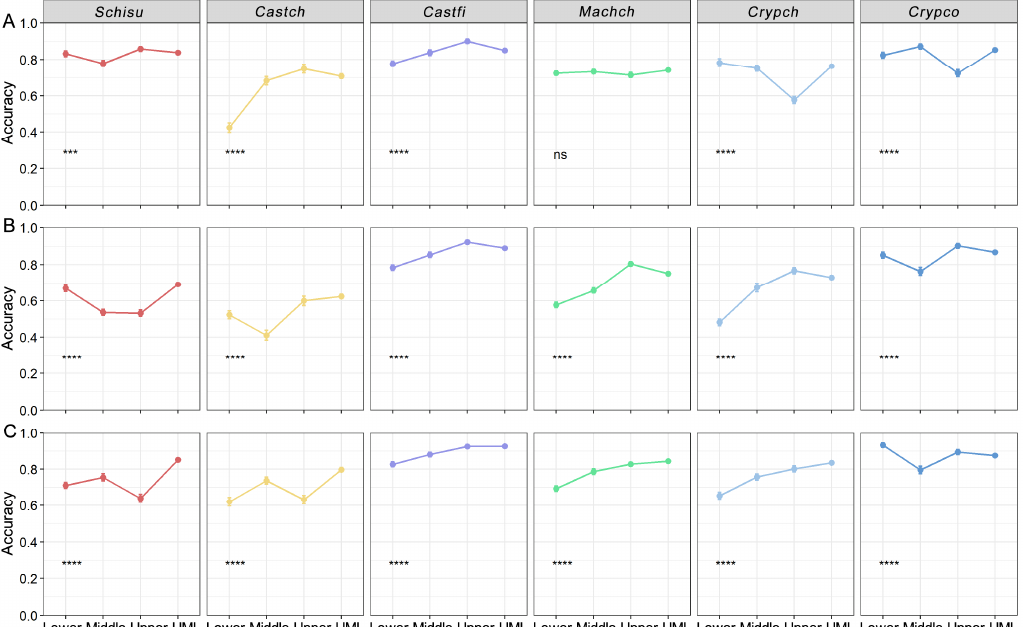
Figure 7. Variation of classification accuracies in different canopy layers of individual trees based on ( A ) the LFT dataset, ( B ) LHR dataset and ( C ) LFT + LHR dataset. The UML is the pooled dataset of the upper, middle and lower layers. The symbols **** and *** represent significance at the 0.0001 and 0.001 levels, respectively. The symbol ns indicates no significant difference ( p > 0.05).